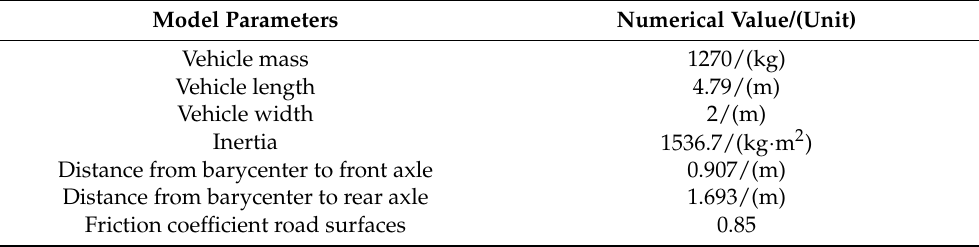
Table 1. Vehicle model parameters.